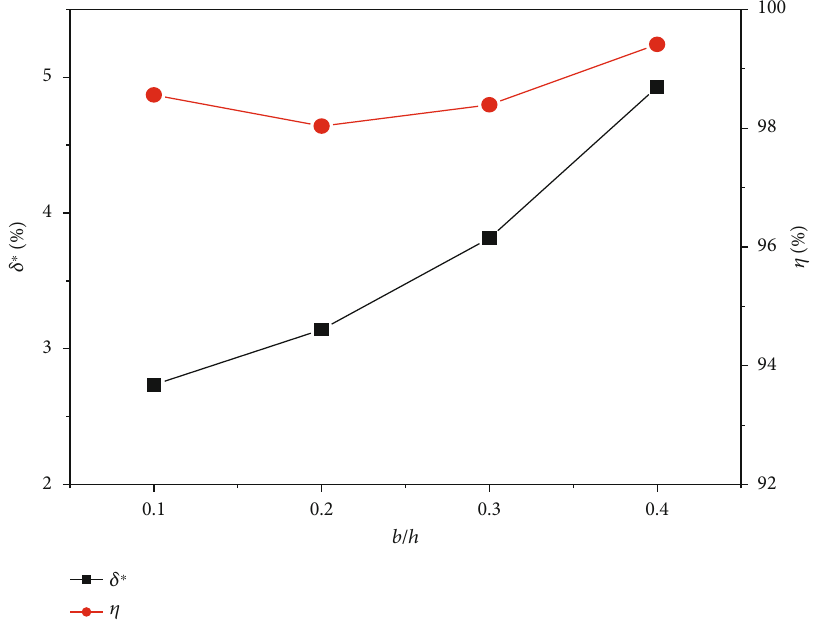
Figure 12: Total pressure loss and combustion e ffi ciency under di ff erent b / h